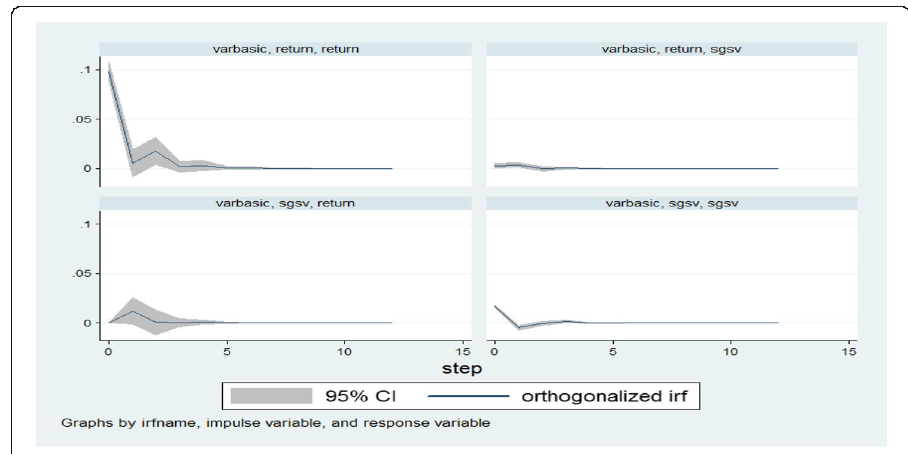
Fig. 1 Impulse-Response Function Analysis (RETURN-SGSV)